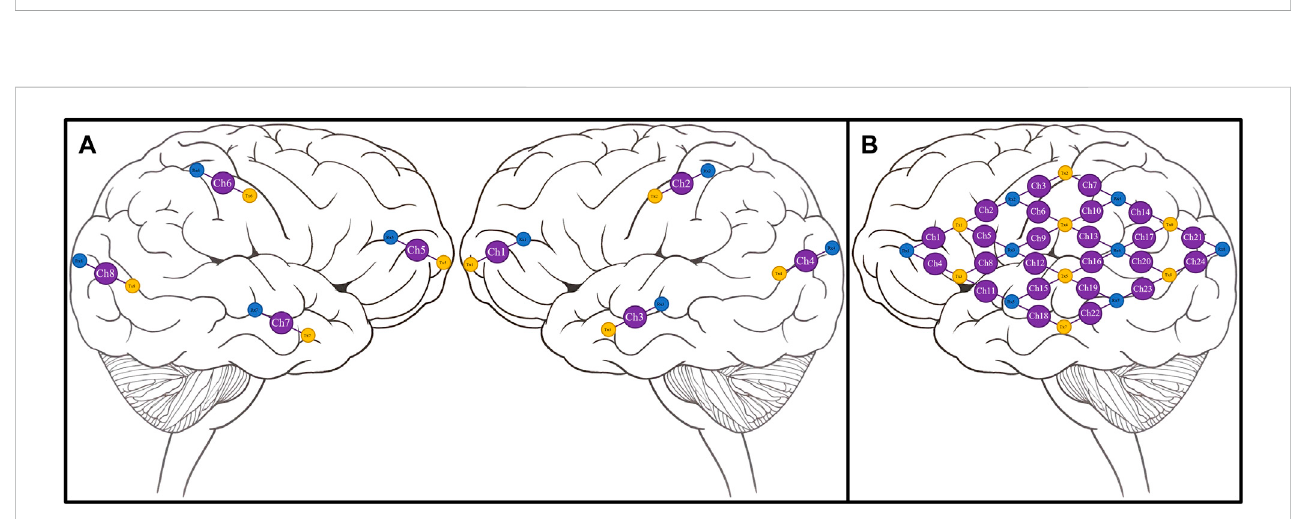
period. An of pure cerebral Ltd., Cambridge) signals (short channel subtracted from normal channel) connected to the data streams from the two systems. from a single channel are shown in Figure 3 along with the Signals from all the monitoring devices described below niABP signal.